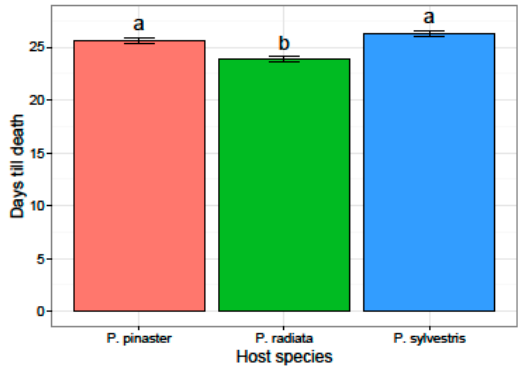
Figure 2. Area under the disease progress curve (AUDPC) values of the three Pinus species inoculated. Different letters above bars indicate significant differences in AUDPC values.